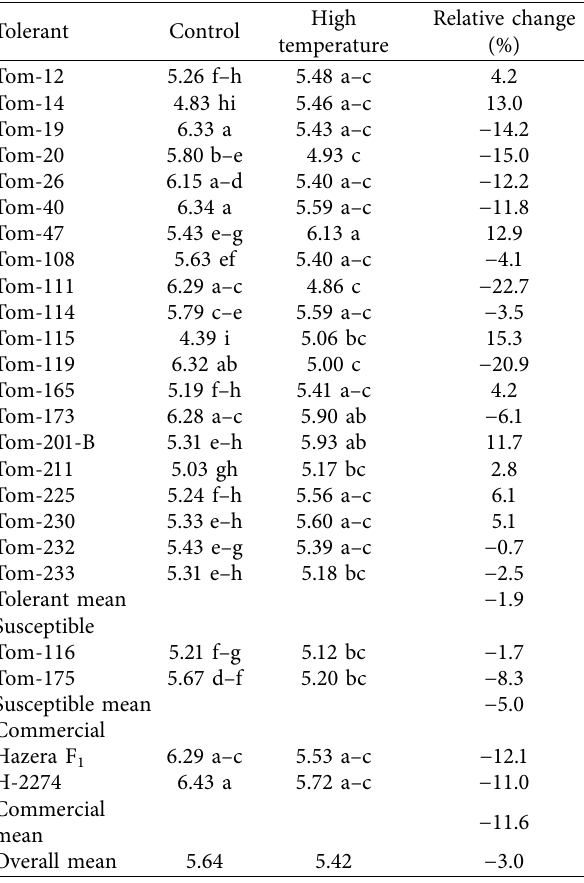
Table 6: EC values of tomato fruits grown in control and high- temperature stress (dSm − 1